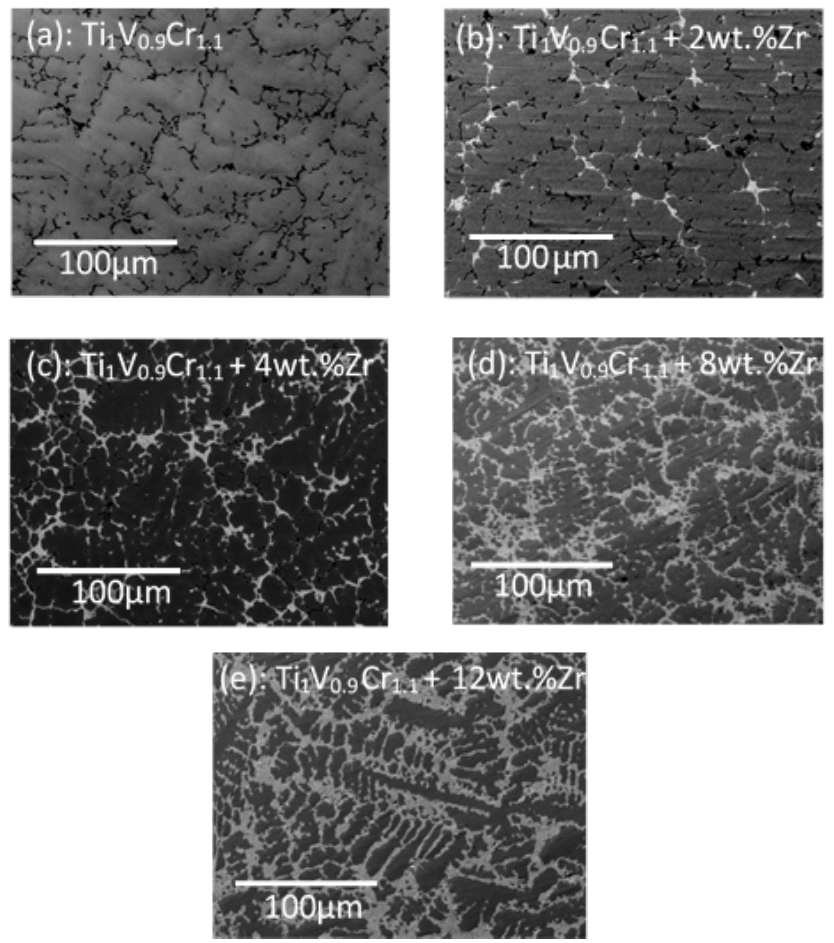
Figure 1. Backscattered electrons (BSE) micrographs of: Ti 1 V 0.9 Cr 1.1 + x wt % Zr with x = 0 (a); 2 (b); 4 (c); 8 (d); and 12 (e).